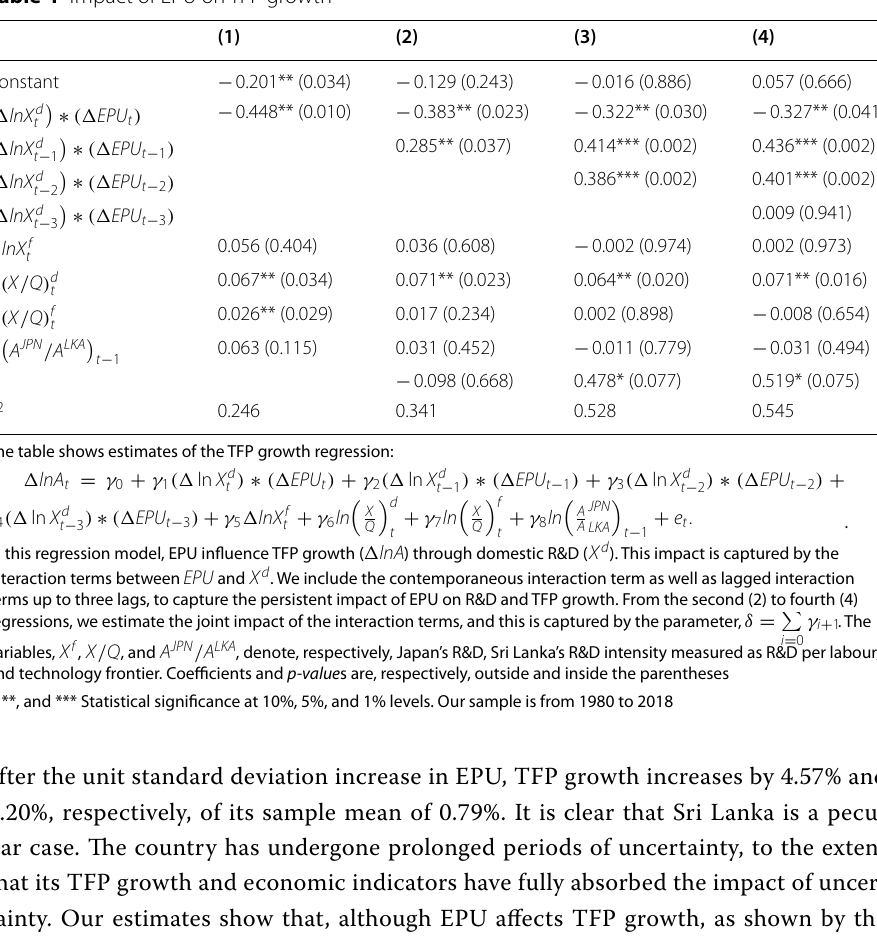
Table 4 Impact of EPU on TFP